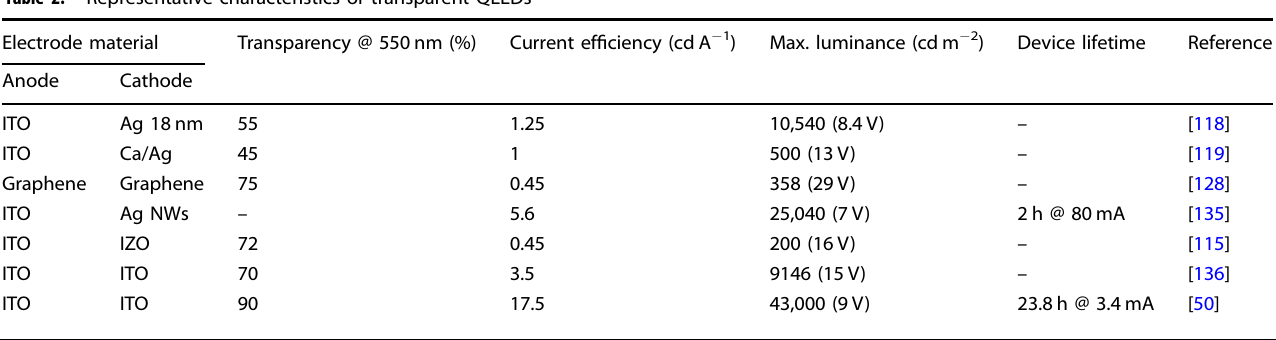
Table 2. Representative characteristics of transparent